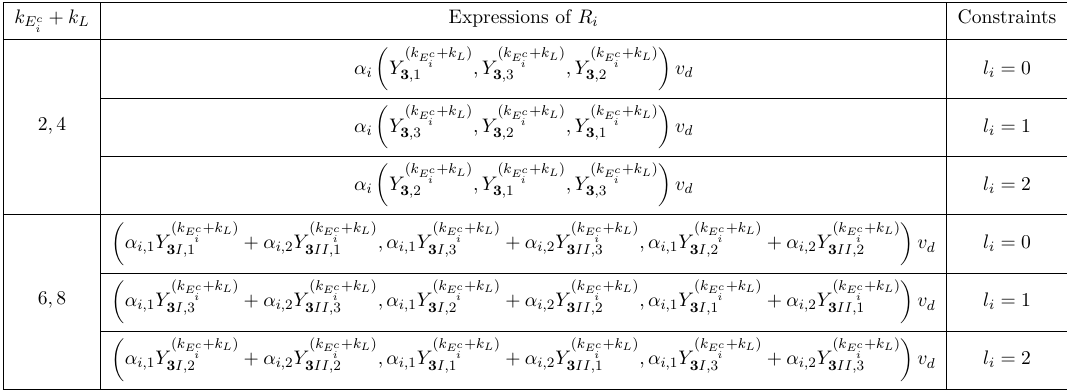
, α and α are Yukawa coupling i i, 1 i, 2